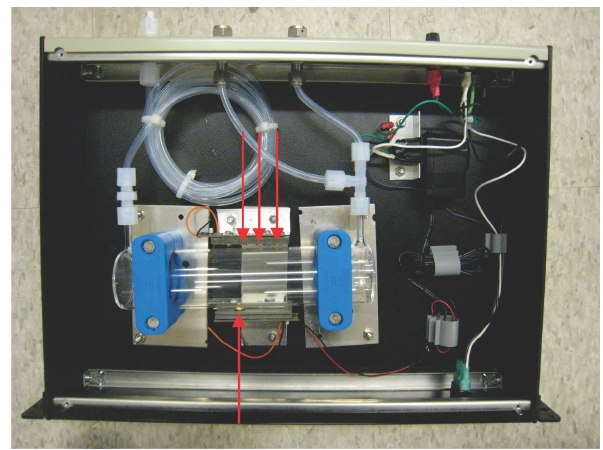
Figure 1. Photograph of the UV-LED photochemical source. The red arrows indicate the position of the